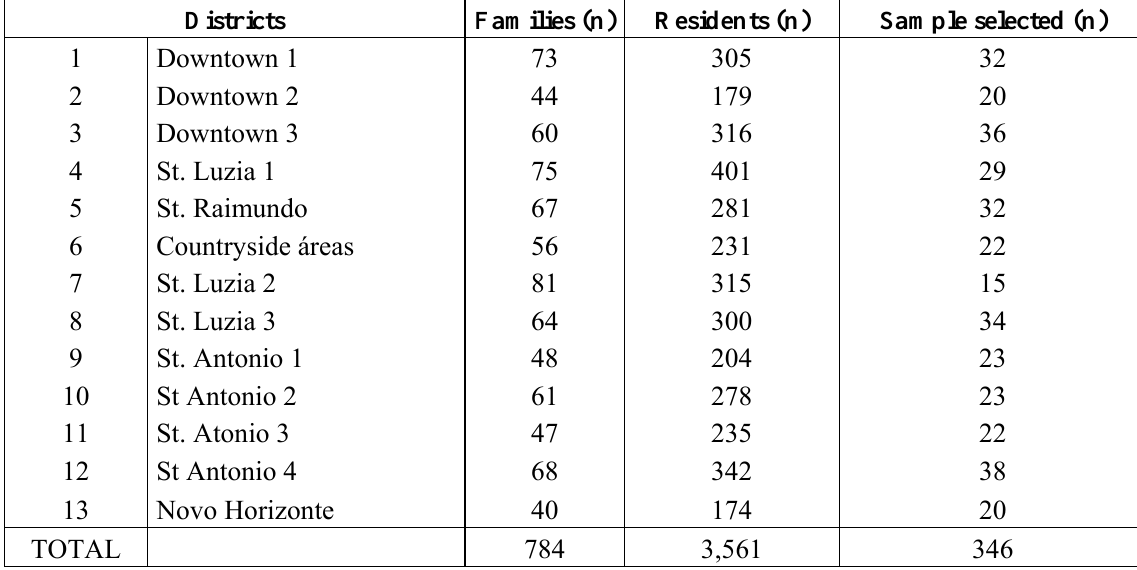
Table 1. Distribution of the number of families, residents and people in the study micro- areas (Caapiranga, AM, Brazil,